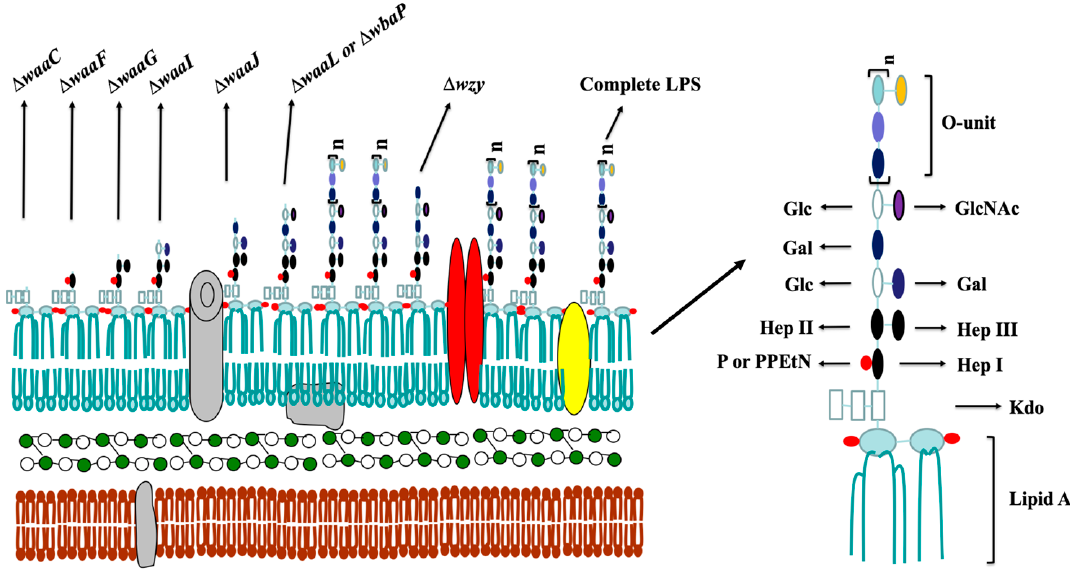
Figure 1. Schematic molecular model of S. Typhimurium cell wall structure. The Salmonella cell wall comprises the inner membrane, the periplasmic space filled with a gel-like matrix and the outer membrane. The inner membrane is the innermost component, whereas the outer membrane is the outermost impermeable structure, which is a bilayer consisting of a phospholipid layer on the inner side, and a lipopolysaccharide layer towards the outer side, as well as lipoproteins anchored into the membrane. Deletion of the specific gene responsible for lipopolysaccharide (LPS) synthesis would lead to truncation of LPS, thus resulting in the membrane rearrangement and altering the amounts and categories of lipoproteins. The figure represents the types of truncated LPS in this study. (Kdo, 3-deoxy- D -mannooctulosonic acid; PPEtN, pyrophosphorylethanolamine; Hep, heptose; GlcNAc, N -acetylglucosamine; Glc, glucose; Gal, galactose; P, phosphate). Deletion of waaC encoding heptosyltransferase I leads to a deep rough LPS structure carrying only Kdo-lipid A (Re); deletion of waaF encoding heptosyltransferase II results in a mutant generating a LPS structure with lipid A and a truncated inner core (Rd2); deletion of waaG encoding a glycosyltransferase leads to the Rd1 type of LPS lacking the outer core, and consequently, waaI and waaJ mutants produce the truncated core phenotype of Rb3 and Rb2, respectively; deletion of both waaL encoding O -antigen ligase and wbaP encoding Und-P galactose phosphotransferase leads to the production of core-lipid A (Ra) in the mutants; wzy encoding O -antigen polymerase is one of three processing genes, the deletion of which results in a mutant generating a semi-rough LPS carrying a single O -antigen unit with a complete lipid A core, and the deletion of rfaH encoding the transcriptional antiterminator leads to the production of the truncated core phenotype